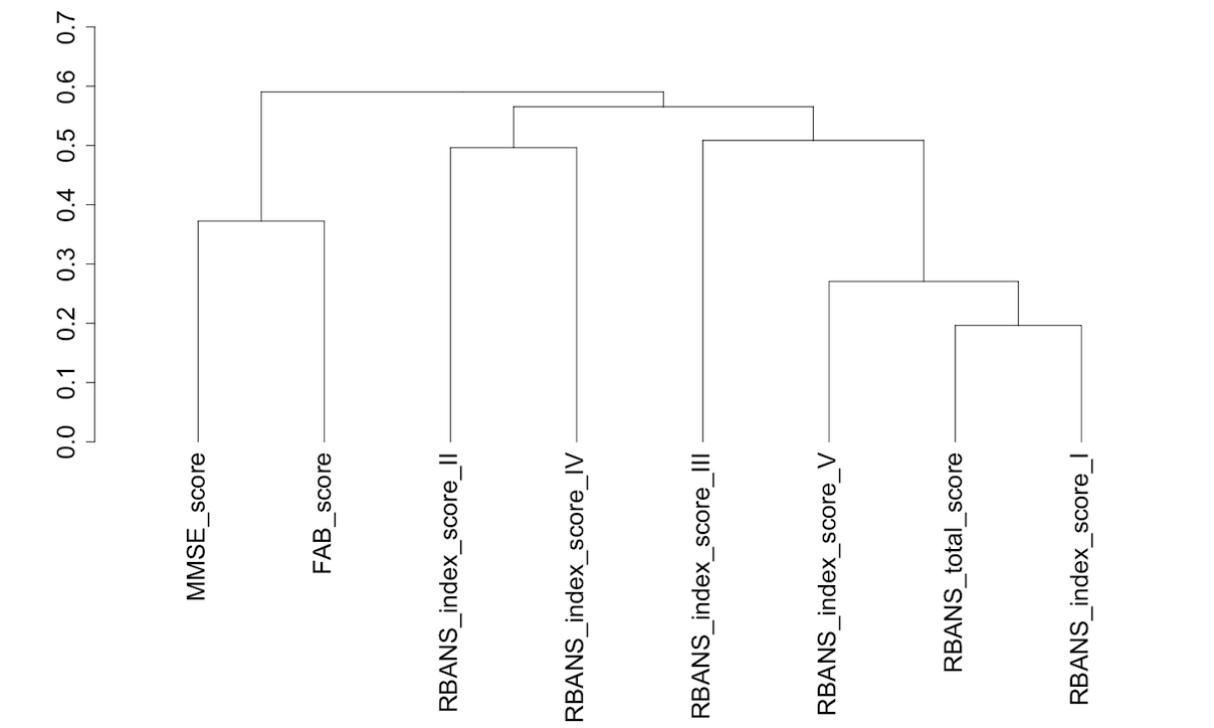
Figure 7. Hierarchical clustering of variables depicted as a dendrogram showing strong relationships between clinical assessment scores from the RBANS, FAB, and MMSE assessments. The variable descriptors are as follows: MMSE_score, Mini-Mental State Examination total score; FAB_score, Frontal Assessment Battery total score; RBANS_index_score_I, Repeatable Battery for the Assessment of Neuropsychological Status (RBANS)